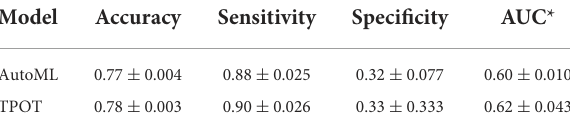
TABLE 7 Results for the auto ML models for 3 years.